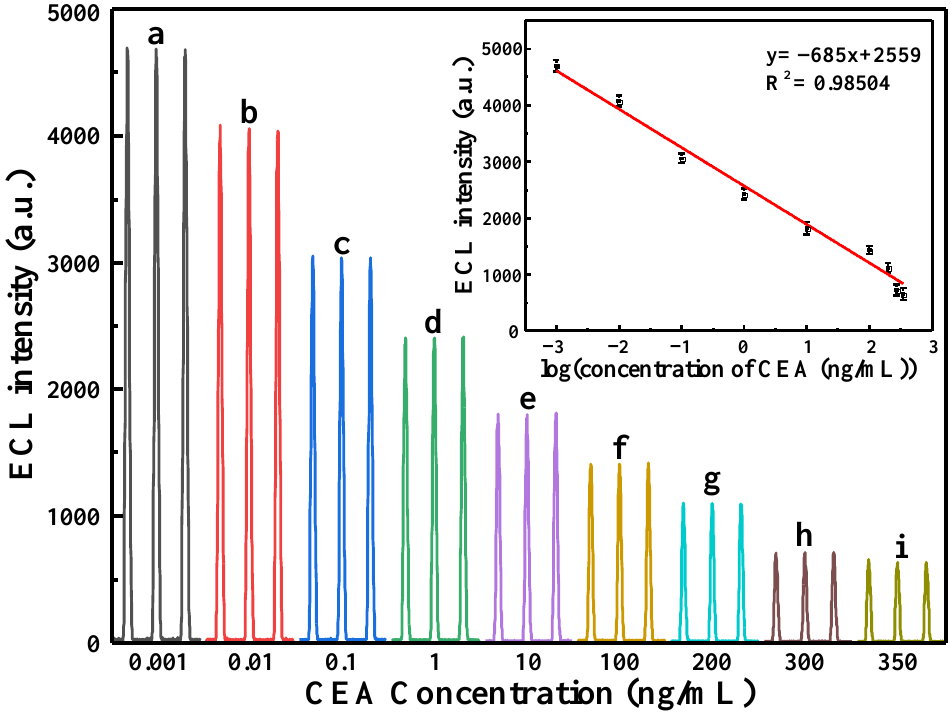
Figure 7. The ECL curve for quantitative detection using GCE/Ru-Au-WS 2 /Ab/BSA, the antigen concentration from left to right is: ( a ) 0.001, ( b ) 0.01, ( c ) 0.1, ( d ) 1, ( e ) 10, ( f ) 100, ( g ) 200, ( h ) 300, ( i ) 350 ng·mL −1 , the inset shows the linear relationship between ECL signal and antigen concentration.